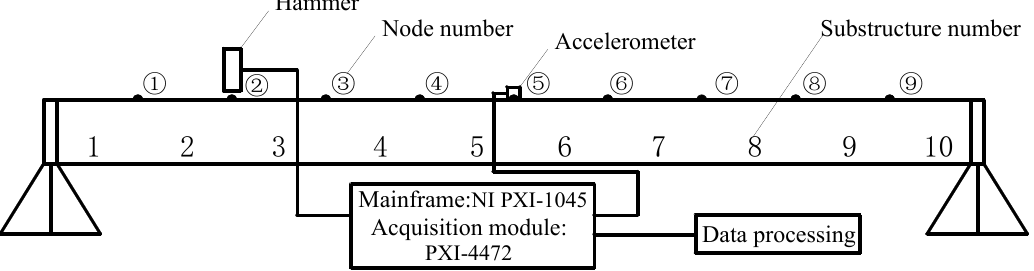
Figure 13. Test model of the pipe structure.